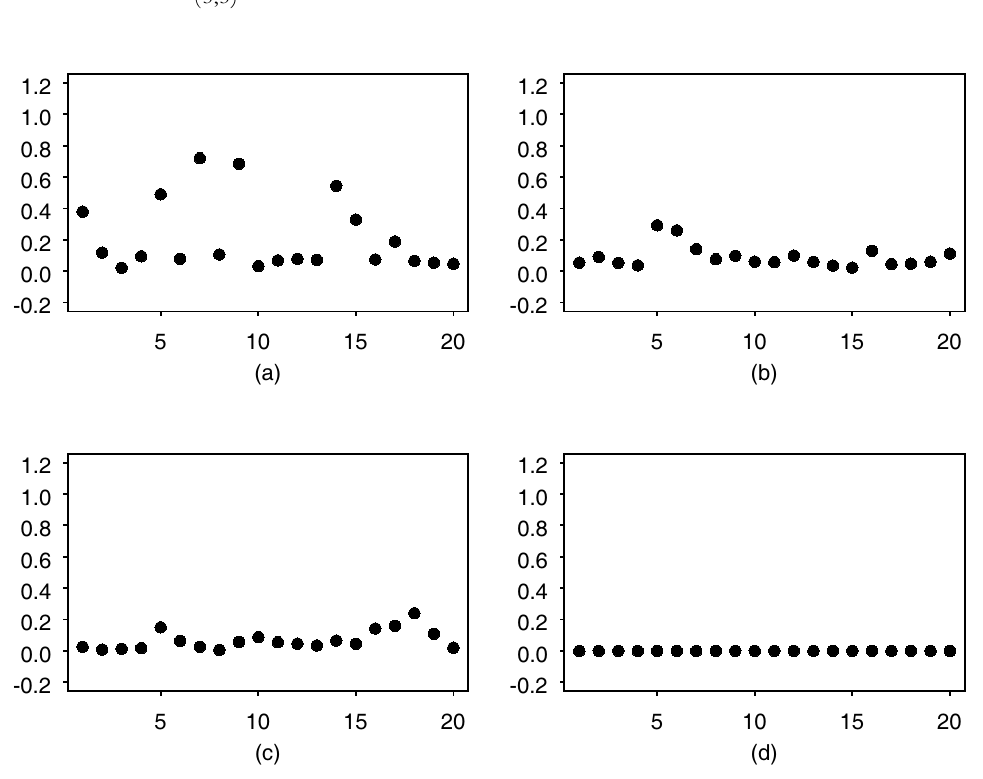
( ; x) (x) s B g g (cid:16) , (symbol (cid:640) ), where the Bernstein-type estimates Figure 4 – The difference ( ) m ( ) ( ; x) s B are obtained as (11), and 1 (x) ( ) g x x (cid:16) (cid:32) , for 20 samples of size n , from independent m 2 1 uniform distributions on the interval (0,1)